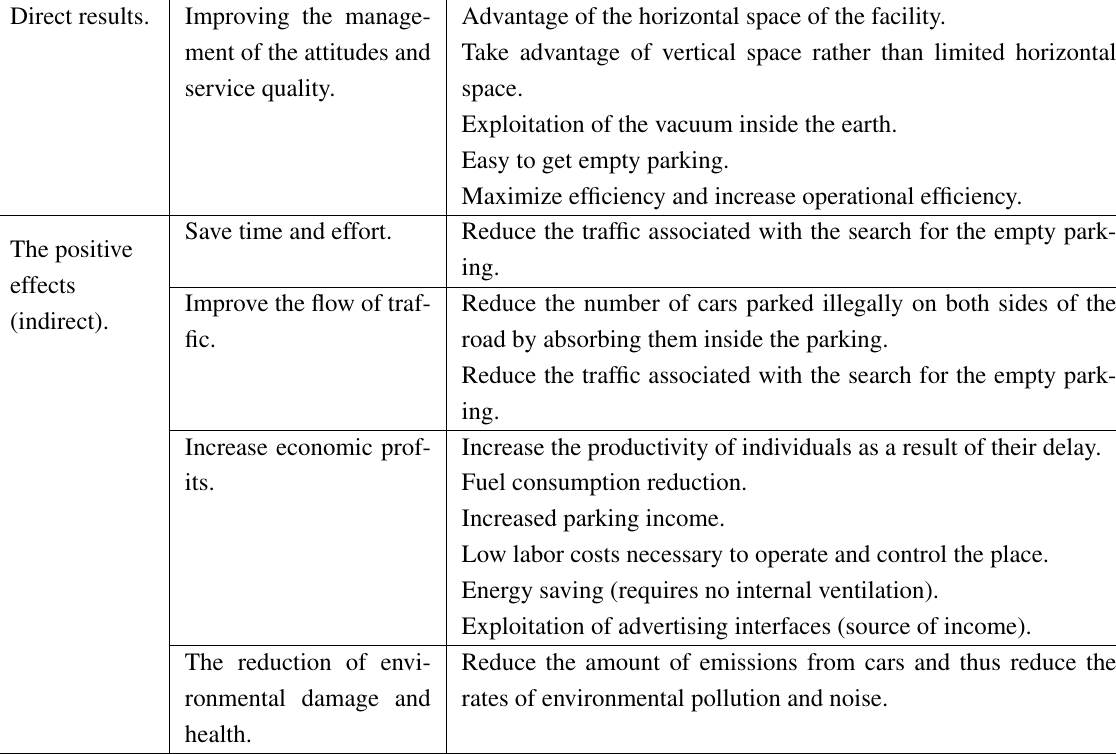
Table 5. Results of Automated parking system and the positive effects. (Adeeb, 2016). Direct results.